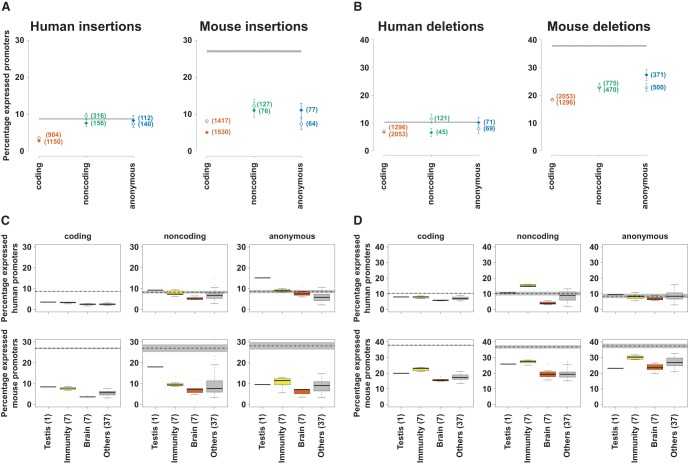
Recent promoter insertions and deletions in the human and mouse lineages. (A,B) The percentage of promoters of a particular class and expression profile which have been recently inserted (A) or deleted (B) in the human and mouse lineages. The closed diamonds represent broadly expressed promoters, while open diamonds show results for tissue-restricted promoters. The numbers of promoters in each category are shown in parentheses next to these points. The error bars represent the 95% confidence interval from 1000 samplings of the data with replacement. The gray bar shows the same 95% confidence interval for genome permuted intervals. The dashed line describes the mean of this expected distribution. (C,D) Percentage of promoters with tissue-biased expression that were inserted (C) or deleted (D), subdivided by biased tissue expression, where the number of samples for each tissue (described in Fig. 1F) is shown in parentheses. The gray bars show the 95% confidence interval for genome permuted intervals for each promoter class, while the dashed line shows the mean of this distribution.